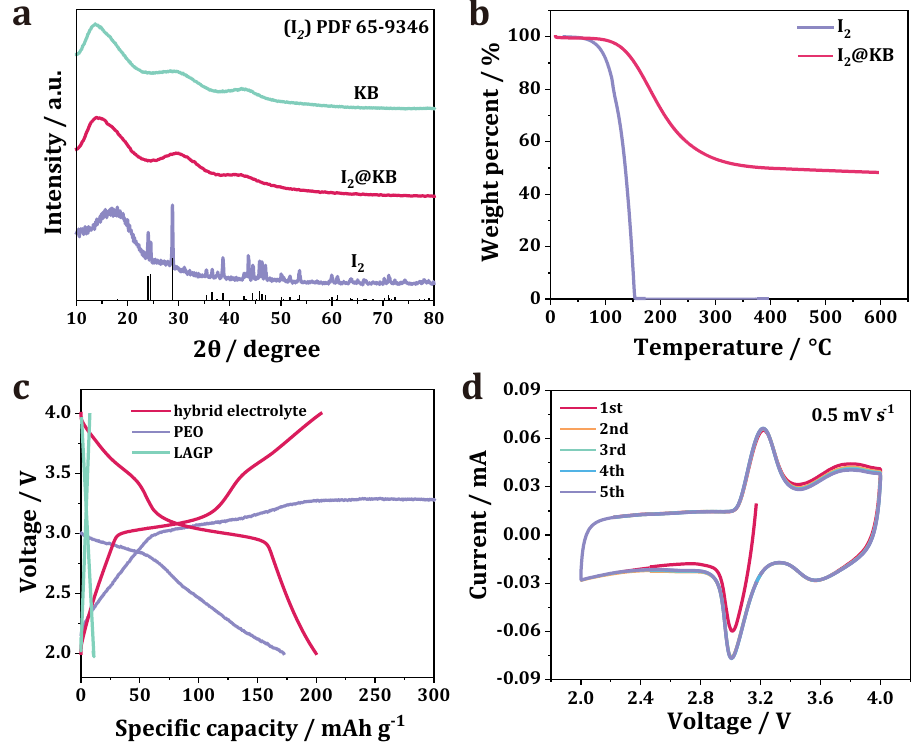
Fig. 2 Characterization of I 2 @KB cathode and its electrochemical behavior. a XRD pattern of KB, I 2 and I 2 @KB. b Thermogravimetric analysis curves of I 2 and I 2 @KB. c The discharge/charge curves of all-solid-state LIB based on PEO electrolyte, LAGP electrolyte and hybrid electrolyte. d CV curves of all-solid- state LIB at sweeping rate of 0.5 mV s − 1 for fi rst 5 respectively, instead of a single slope reported in the previous the I 3 − /I − redox couple commonly reported in liquid LIBs 5 . solid-state LIB 12 . This indicates a new battery chemistry for all- Previous studies have limited the cut-off voltage below 3.6 V, and solid-state LIB promoted by the hybrid electrolyte. The cyclic the other pair of redox couple at higher voltage (3.6/3.65 V) was voltammetry (CV) results also con fi rmed a two-step reaction usually incompletely displayed 8,16 – 18 . This redox couple was most likely corresponding to the I 5 − /I 3 − , which would be discussed in process (Fig. 2d). At a scan rate of 0.5 mV s − 1 , two pairs of redox couples located at 3.6/3.65 V and 3/3.2 V were observed, the following section of the reaction mechanism. From the second respectively. The pair of peaks at 3/3.2 V could be attributed to to the fi fth cycle, the CV curves perfectly overlapped with each